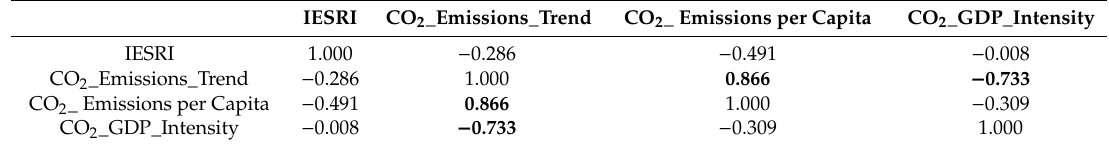
Table 20. Pearson Correlation parameters from the Energy Use Intensity group.